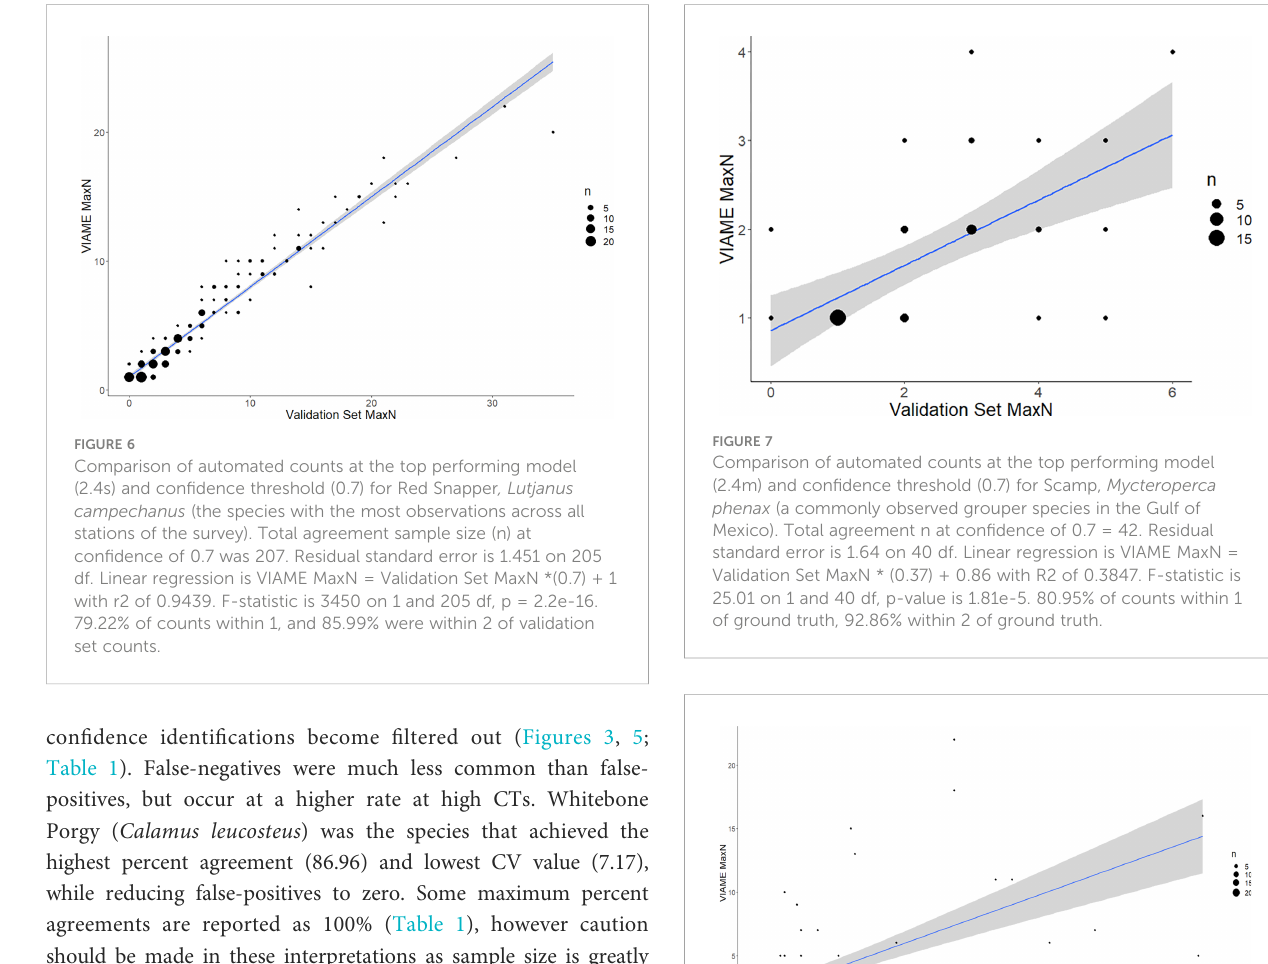
FIGURE 8 Comparison of automated counts at the top performing model (2.4m) and con fi dence threshold (0.6) for Vermilion Snapper, Rhomboplites aurorubens (a commonly observed snapper species in the Gulf of Mexico). Total agreement n at con fi dence of 0.6 = 94. Residual standard error is 16.8 on 92 df. Linear regression is VIAME MaxN = Manual MaxN (0.12) + 1.9 with R2 of 0.3963. F-statistic is 60.4 on 1 and 92 df, p-value is 1.073-11. 54.26% of counts within 1 of ground truth, 63.83% within 2 of ground